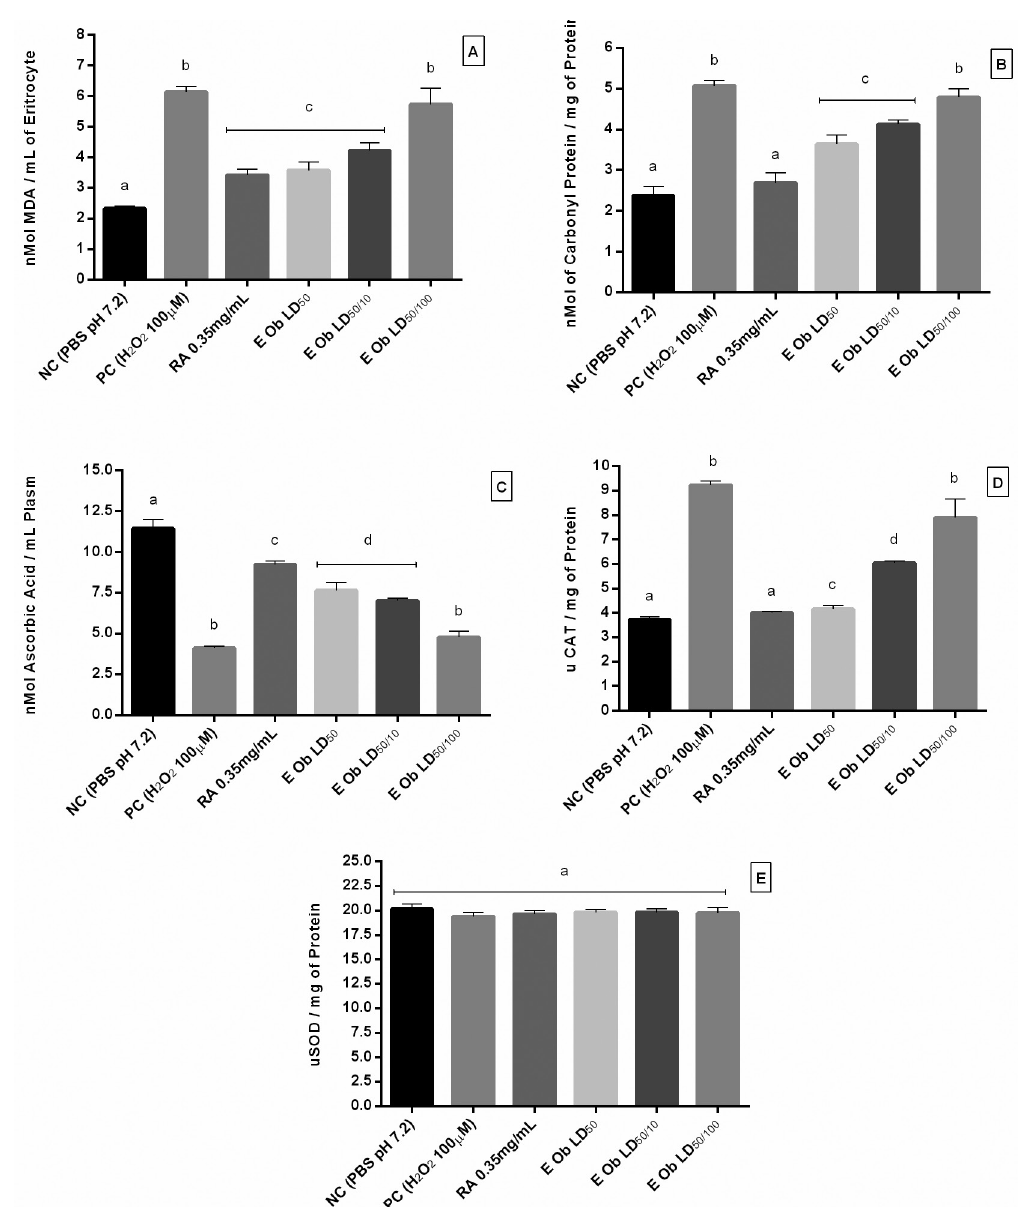
FIGURE 2 - Effects of O. basilicum extract in oxidative parameters of human leukocytes in culture subject to hydrogen peroxide. In A: lipid peroxidation; B; carbonyl contents; C: ascorbic acid; D: catalase activity; E: superoxide dismutase activity. NC: negative control; PC: positive control; RA: rosmarinic acid; LD : concentration equals to LD (35.44 µg/mL); LD : 10 times 50 50 50/10 less the concentration of LD (3.544 µg/mL); LD : One hundred times less the concentration of LD (0.3544 µg/mL). Data 50 50/100 50 are expressed as mean ± S.D. Results were confirmed by an experiment that was repeated three times. Different letters represent statistically different results among columns